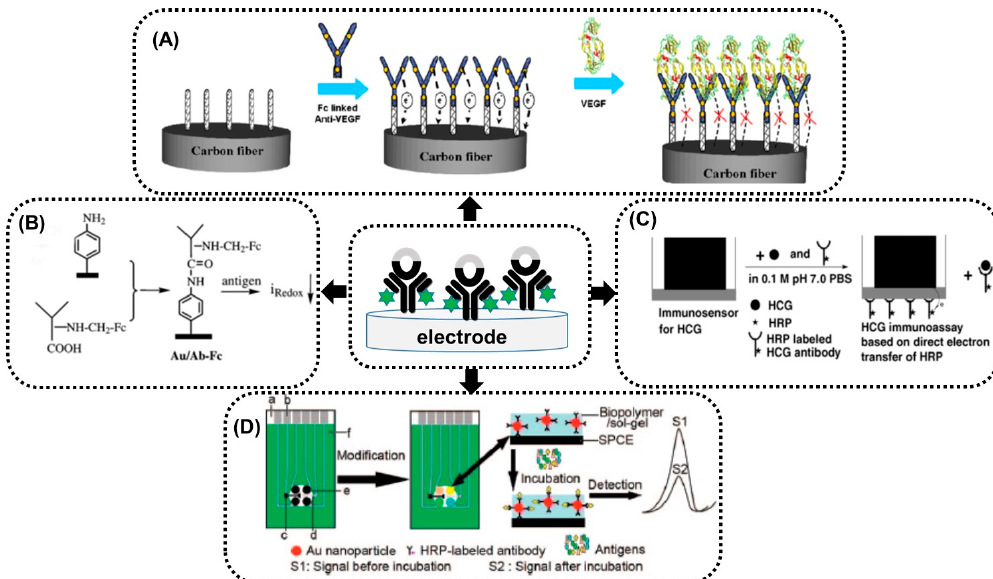
Figure 4. Selected examples of direct signal immunosensors based on electroactive label conjugates. ( A ) Scheme representing the construction of an immunosensor based on ferrocene monocarboxylic acid-tagged anti-VEGF antibodies immobilized on carbon fibre microelectrodes using Jeffamine cross-linker (reprinted with permission from Prabhulkar et al. [50]). ( B ) Procedure of